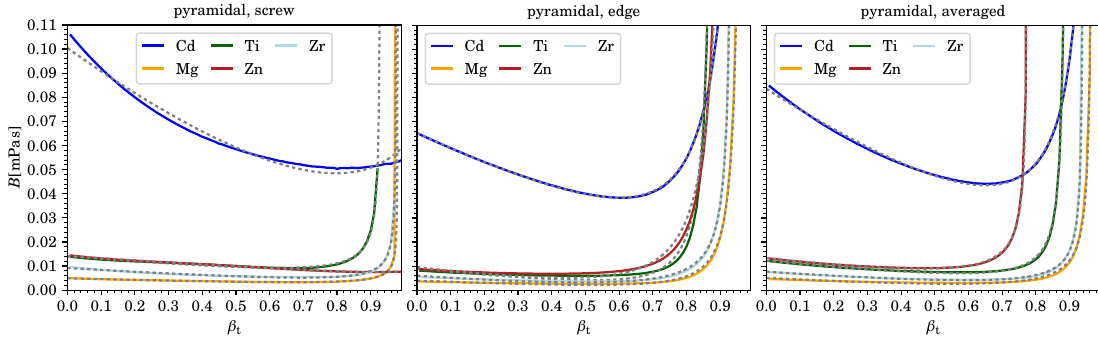
Figure 5. We show the drag coefficient B ( β T ) from phonon wind for pure screw and edge dislocations as well as averaged over all character angles ϑ for pyramidal slip of five hcp metals. Dashed lines represent the fitting functions and β T = v / c T